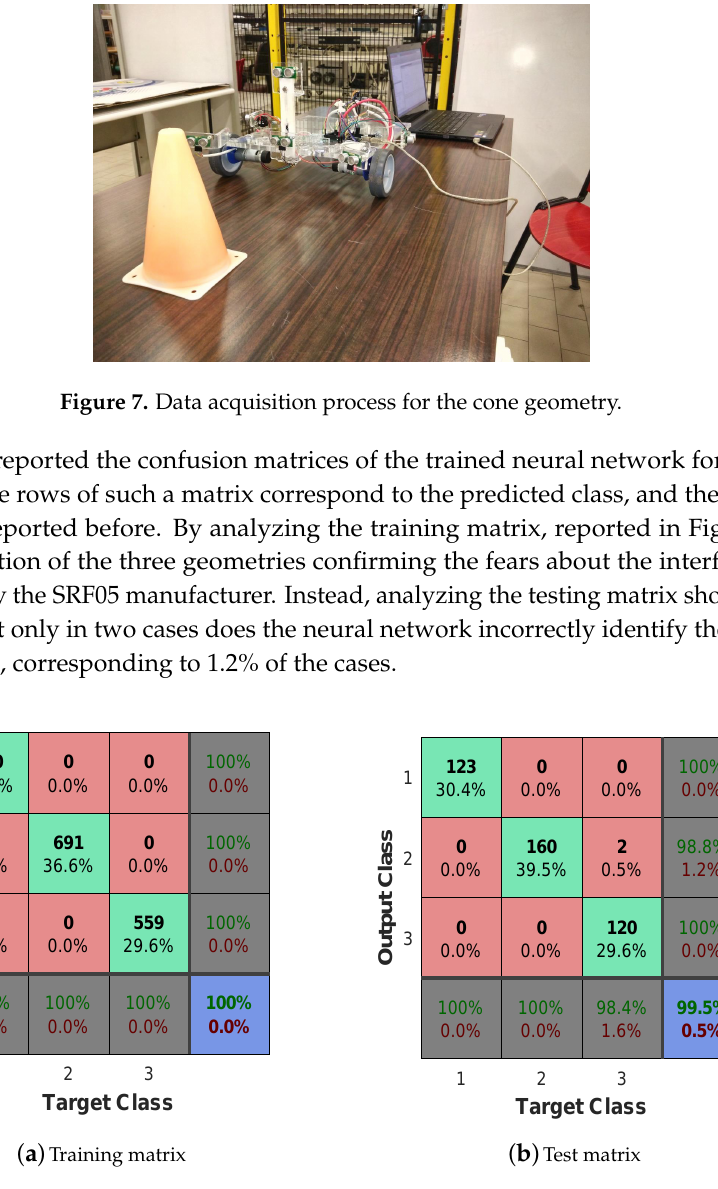
Figure 8. Confusion matrices for the training and test activity for the experimental